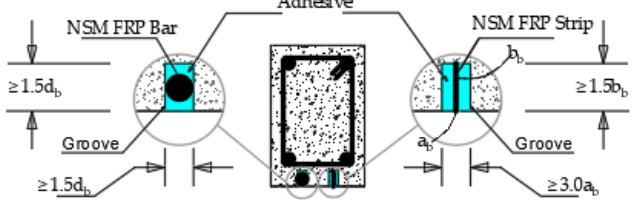
Figure 12. Groove Dimensions for NSM FRP Strengthening systems [78].